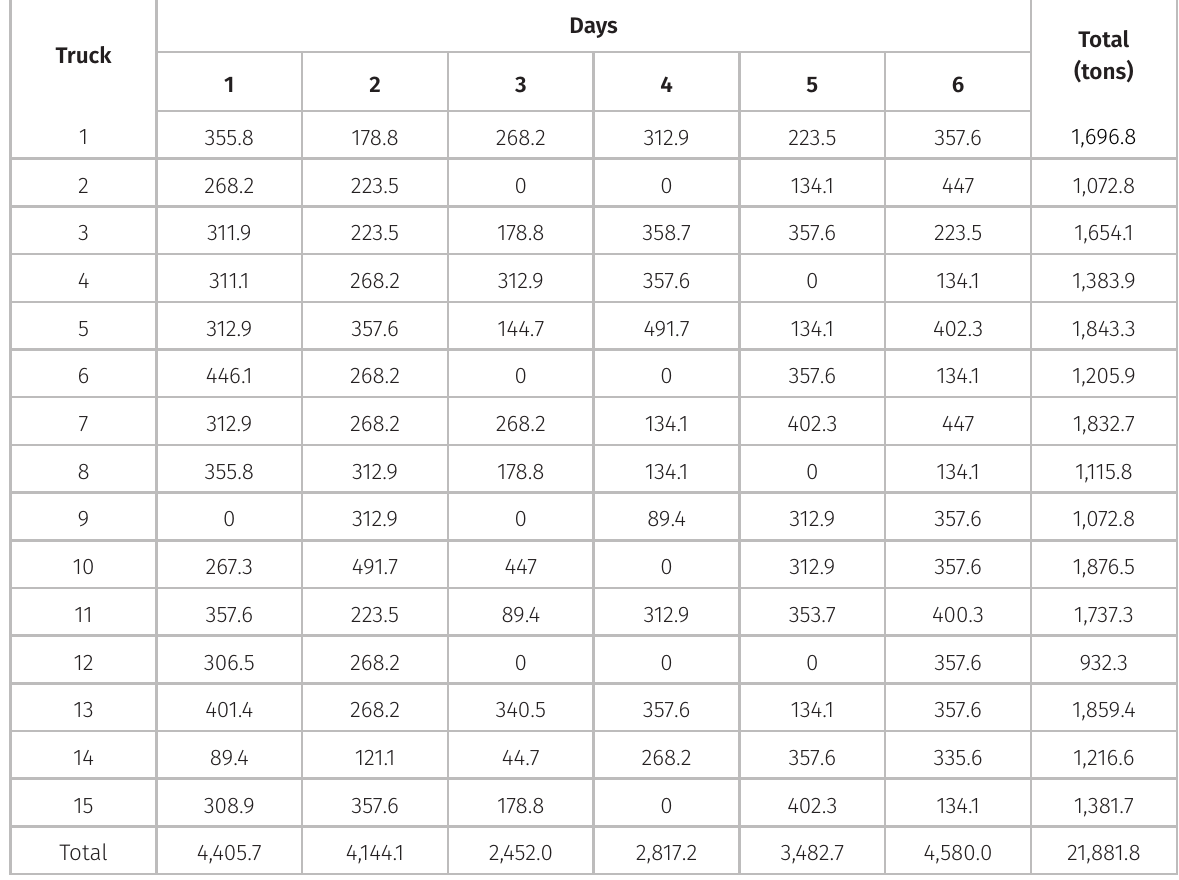
Table III. Lumber weight (ton) transported per truck during the horizon plan.